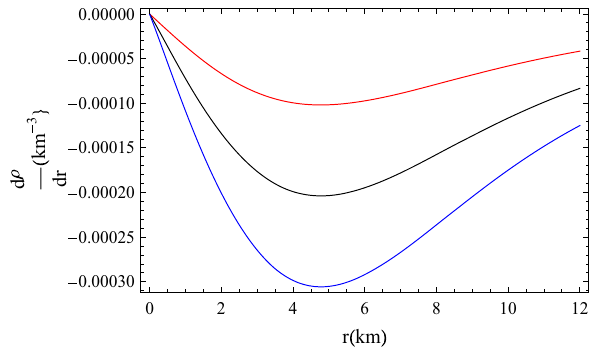
Fig. 6 Radial variation of the energy-density gradient of PSR J0348+0432 for β = 1 (red), β = 2 (black) and β = 3 (blue) (consid- ering α = 0 . 4)